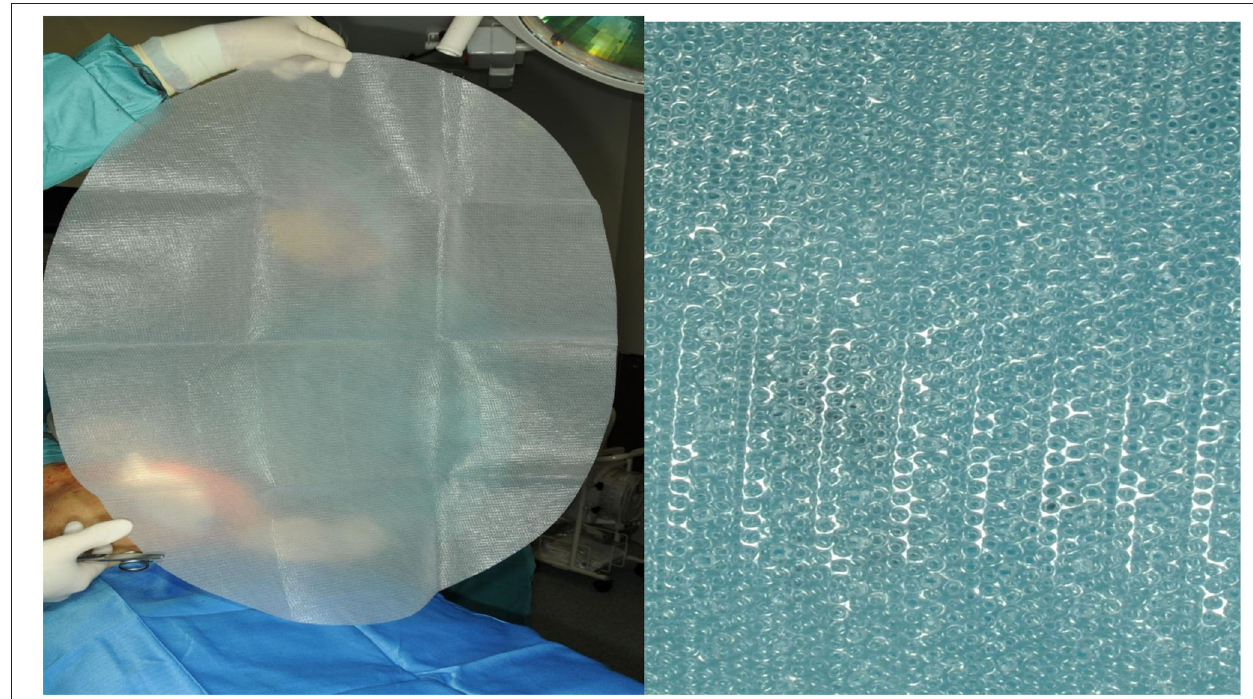
FIGURE 1 | Suprasorb CNP film.